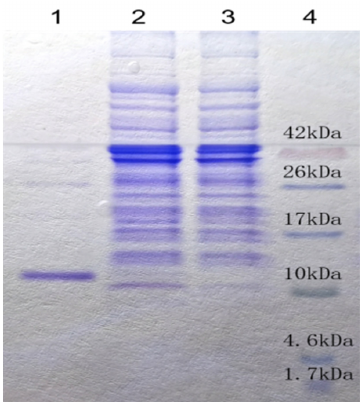
Figure 4. Purified rAj-Tspin was detected on Tricine SDS-PAGE. Lane 1: 10 μ L of purified rAj-Tspin; Lane 2: IPTG-induced expression of recombinant BL21 cells; Lane 3: non-induced expression of re- combinant BL21 cells; Lane 4: spectra multicolor low range protein ladder (Thermo Scientific, Wal- tham MA, USA).